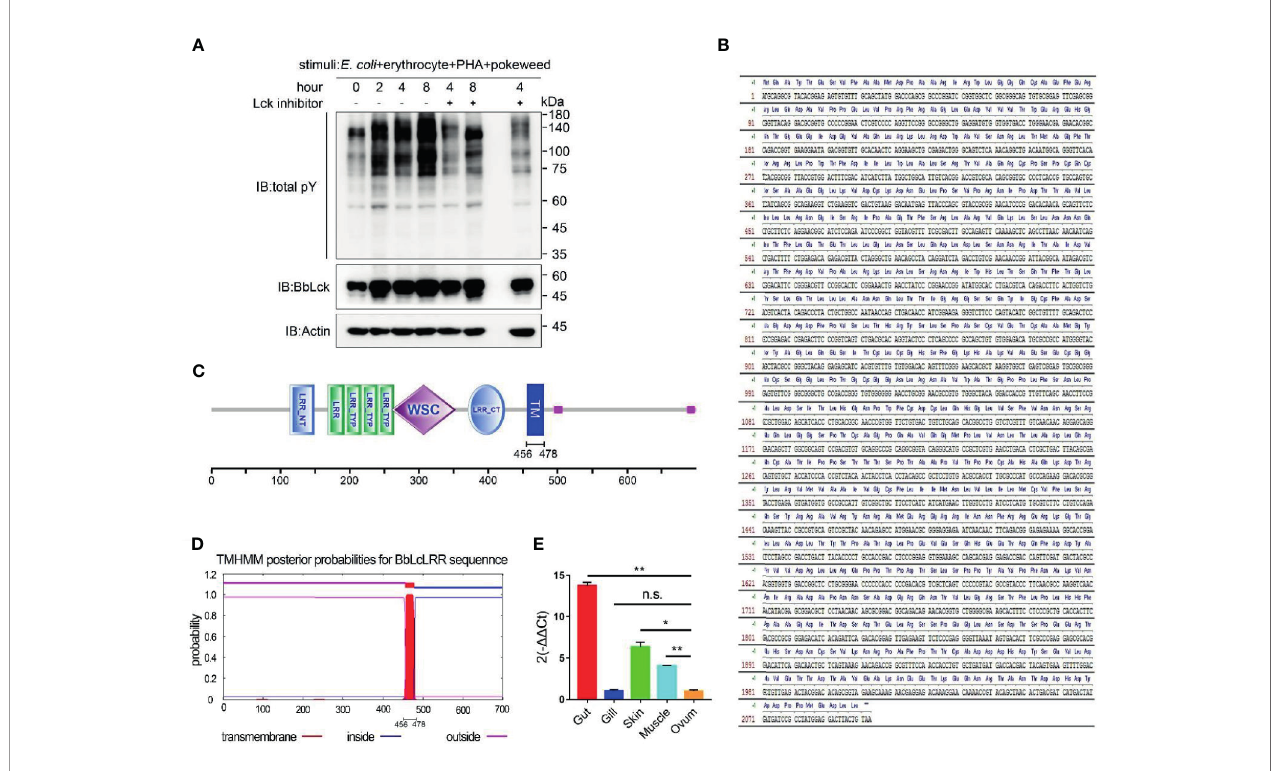
FIGURE 3 | Identi fi cation of BbLcLRR. (A) Tyrosine phosphorylation of gut cellular proteins costimulated by E coli (10 5 ), erythrocytes (10 5 ), PHA (15 m g) and pokeweed (20 m g). Amphioxi were stimulated for the indicated duration in the absence or presence of Lck inhibitor, after which their gut cells were extracted. Tyrosine phosphorylation in whole-cell lysates was detected using the antibody P-Tyr-100. (B) Nucleotide sequence and deduced amino acid sequence of BbLcLRR. (C) Conserved domains prediction of BbLcLRR by SMART prediction tool online. (D) Transmembrane motif of BbLcLRR predicted by TMHMM server 2.0. (E) Relative expression level of BbLcLRR gene in various tissues of Branchiostoma belcheri by qRT-PCR. 2- DD Ct values (normalized to endogenous control 18S) represented the expression of the BbLcLRR gene in various tissues (gut, gill, muscle, skin, ovum) of Branchiostoma belcheri . n.s., not signi fi cant; * P < 0.05, ** P < 0.01 (two-tailed unpaired t -test). The data are presented as the mean (± s.e.m.). Data are representatives of three (A) or two (E) independent